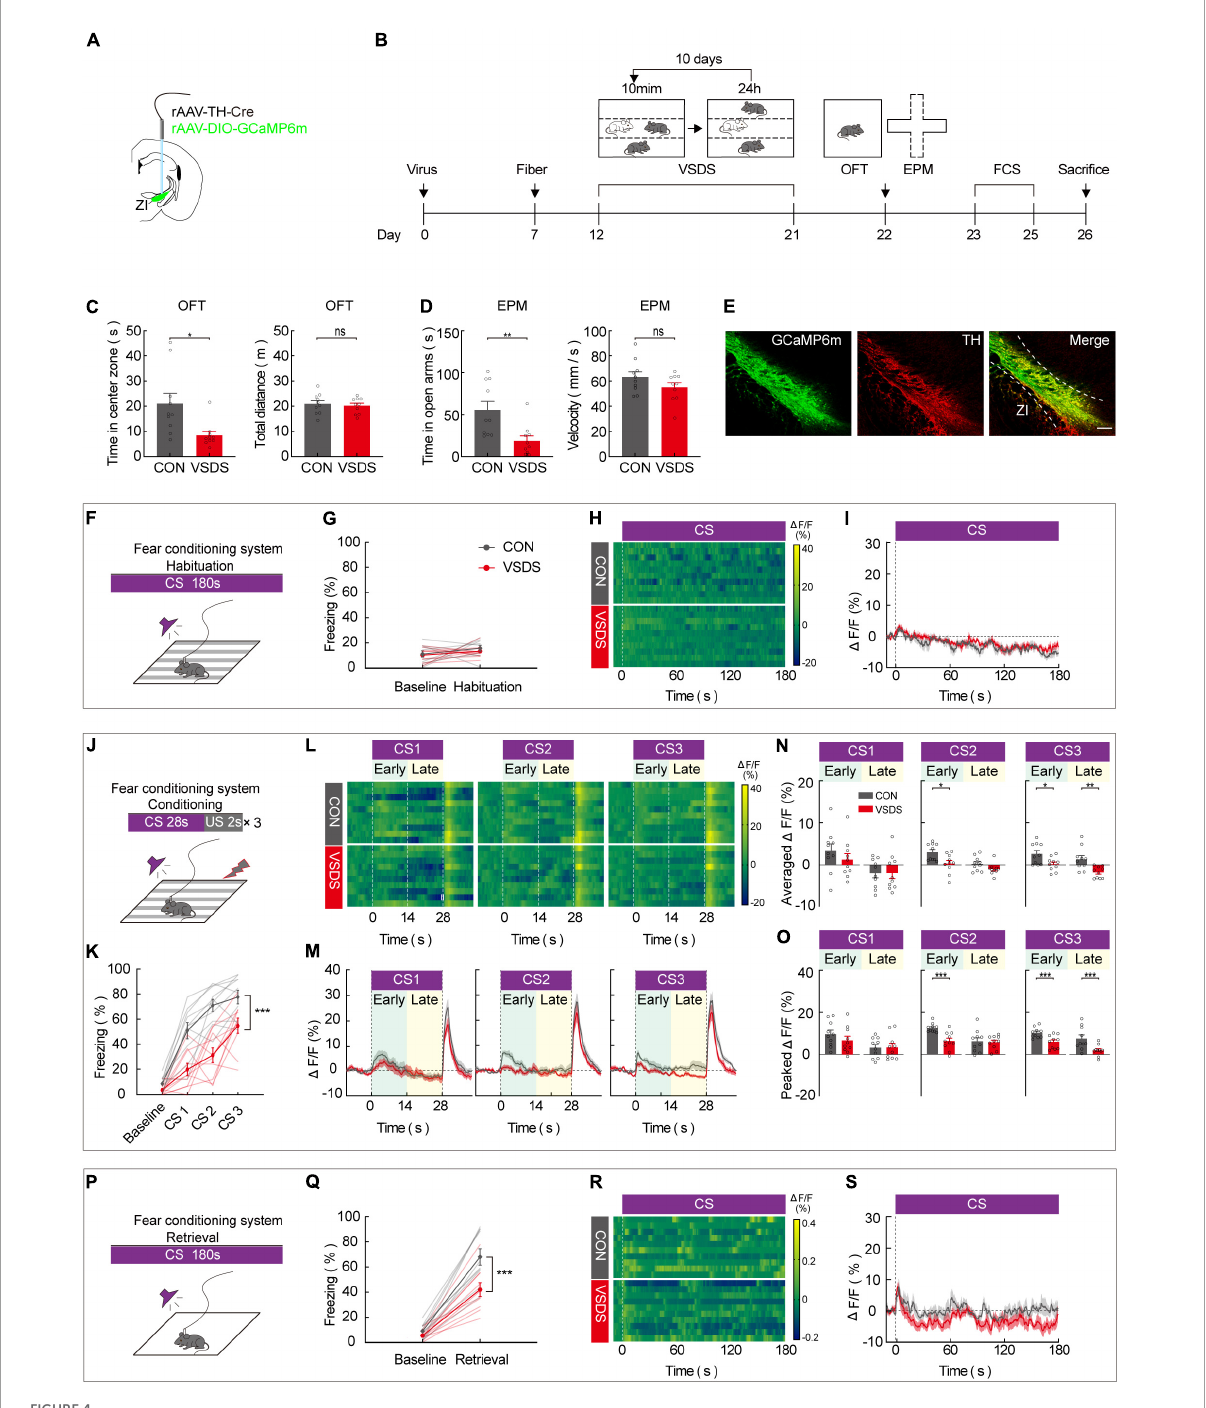
FIGURE4 3C-VSDS suppresses ZI TH + neuron activity during the late stage of CS. (A) Schematic representation of the virus injection and optic fiber implantation. (B) Experimental protocol timeline. (C) Bar graphs represent time in center zone and total distance, respectively, by open field test in control with VSDS mice (unpaired t test, time in the center zone: p = 0.0108, total distance: p = 0.6842. Mean ± SEM n = 10). (D) Bar graphs represent time in open arm and average velocity, respectively, by EPM test in control with VSDS mice (unpaired t -test, time in open arm: p = 0.0055, average velocity: p = 0.2475. Mean ± SEM n = 10). (E) Representative image of GCaMP6m expression in the ZI TH-positive cells dominantly; GCaMP6m is shown in green, TH + is shown in red and co-expressed cells are shown in yellow. Scale bar, 500 µ m. (F-I) Habituation day paradigm. (F) Behavioral methodology. (G) Freezing behavior of control and VSDS mice on habituation day. (Two-way RM ANOVA, group: p = 0.3360, time: p = 0.1371, interaction: p =